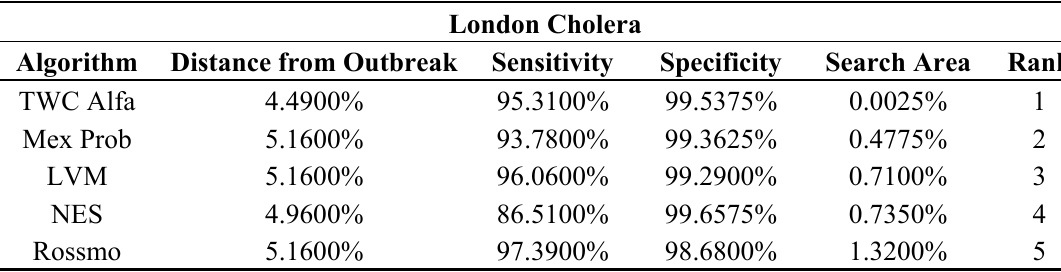
Table 3. London cholera results.